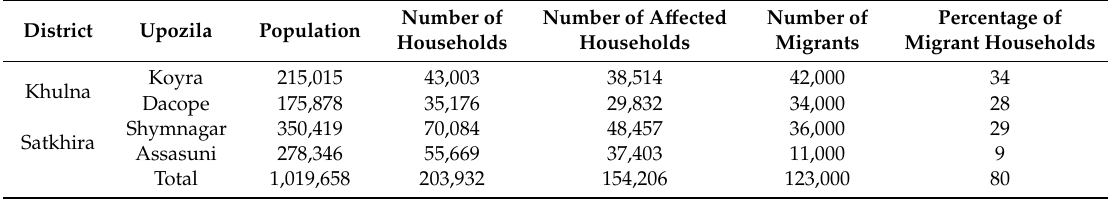
Table 1. Cyclone Aila-a ff ected areas and the number of a ff ected households.